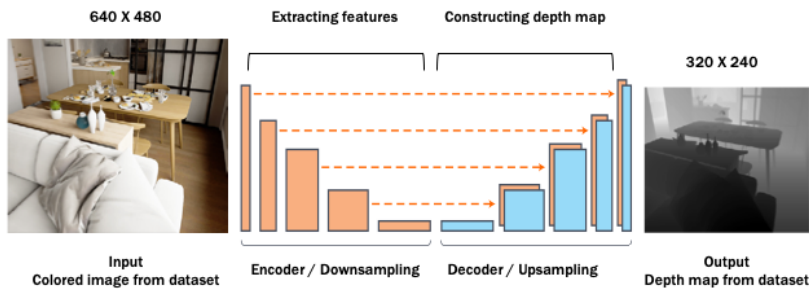
Figure 5. Depth Dense Network [24]. The figure is modified for explanation purposes.